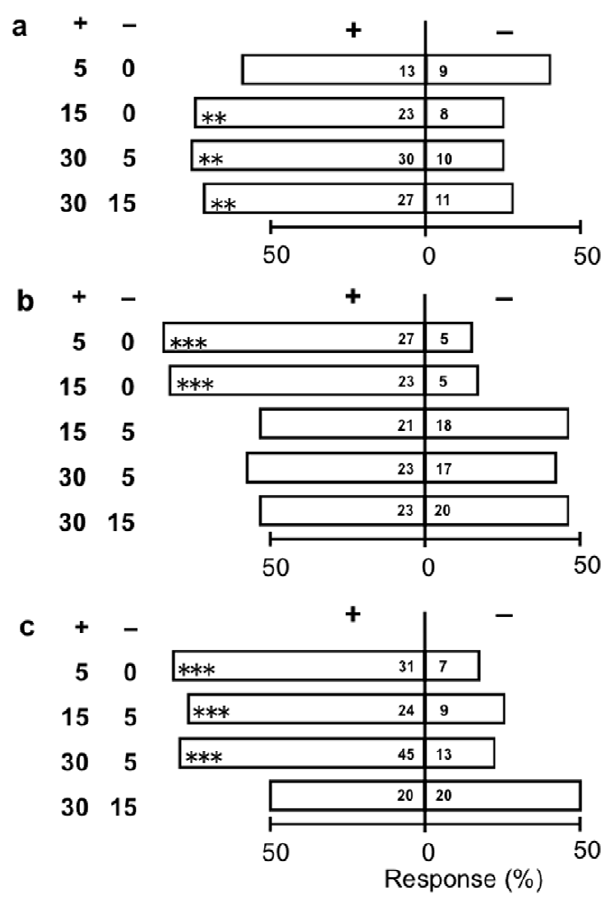
Figure 1. Two-choice tests for the response of parasitoid species to plants differing in herbivore damage : (1a) response of Cotesia glomerata to cabbage ( B. oleracea var. capitata cv Shikidori) damaged by CWB larvae, (1b) response of Cotesia vestalis to cabbage plants (cv Shikidori) damaged by DBM larvae, and (1c) response of Cotesia vestalis to kale ( B. oleracea var acephala ) damaged by DBM larvae. Combinations of two plants ( + , 2 ) with different damage levels (0, 5, 15, 30%) are shown at the left-hand side of the vertical bars. Within each bar expressing response percentage, two numbers refer to totals of parasitoids, that visited respectively the + plant and the – plant offered in the test and asterisks refer to significance level according to replicated G -tests (* 0.01 , P # 0.05; ** 0.001 , P # 0.01; *** P # 0.001). The two-choice results per replicate experiment and the statistics of the replicated G -tests for (1a), (1b) and (1c) are shown respectively in Tables S1, S2 and S3.